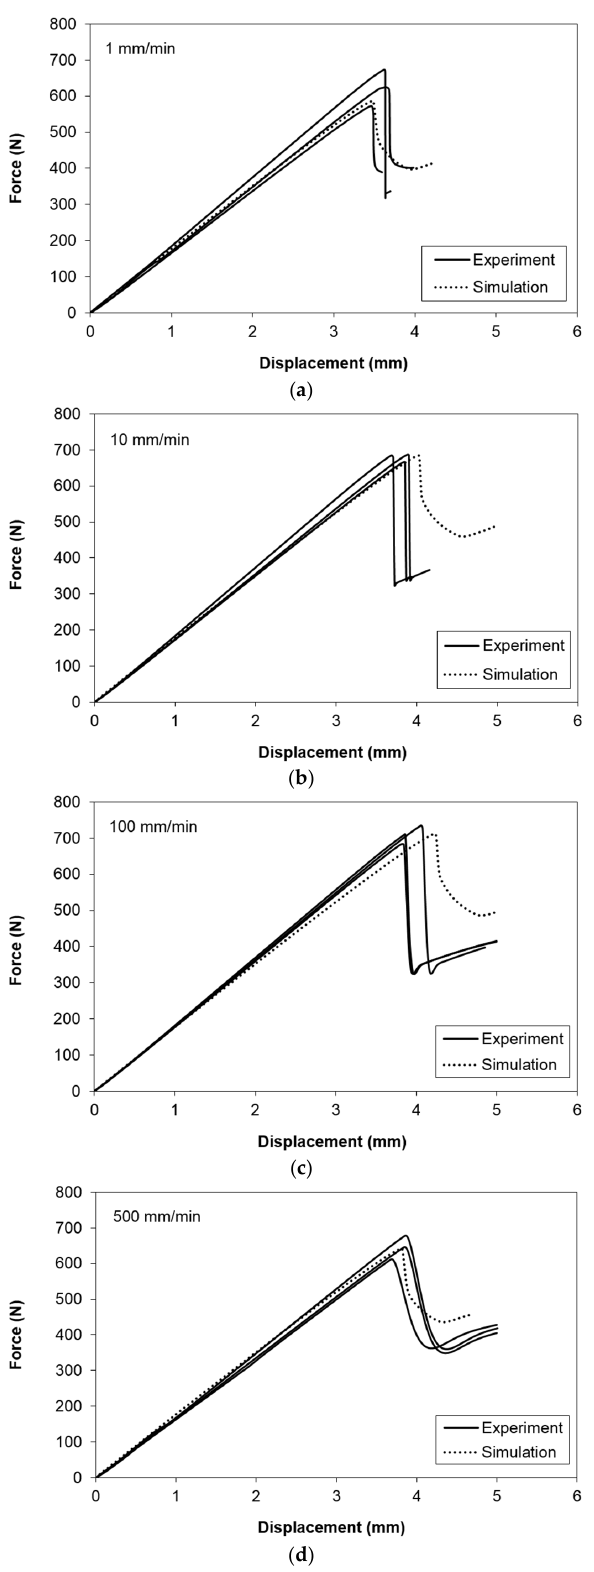
Figure 11. Experimental and numerical force-displacement curves at ( a ) 1 mm/min, ( b ) 10 mm/min, ( c ) 100 mm/min and ( d ) 500